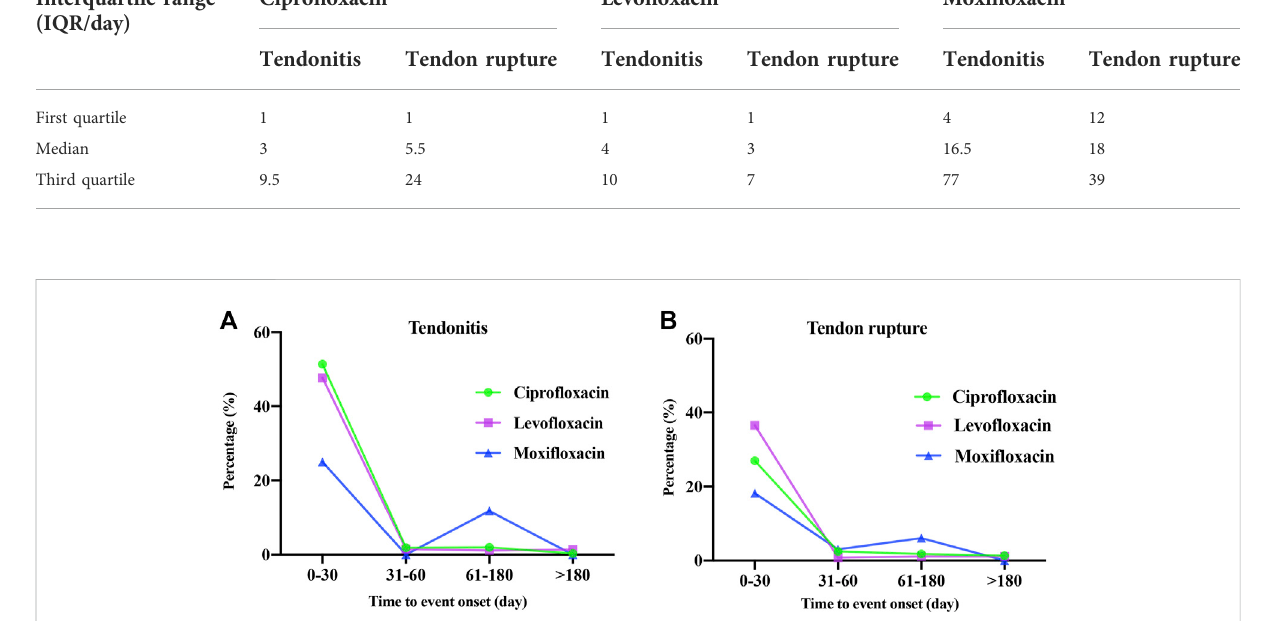
TABLE 4 Onset time of cipro fl oxacin-, levo fl oxacin-, and moxi fl oxacin-associated tendonitis and tendon rupture. Interquartile range (IQR/day)